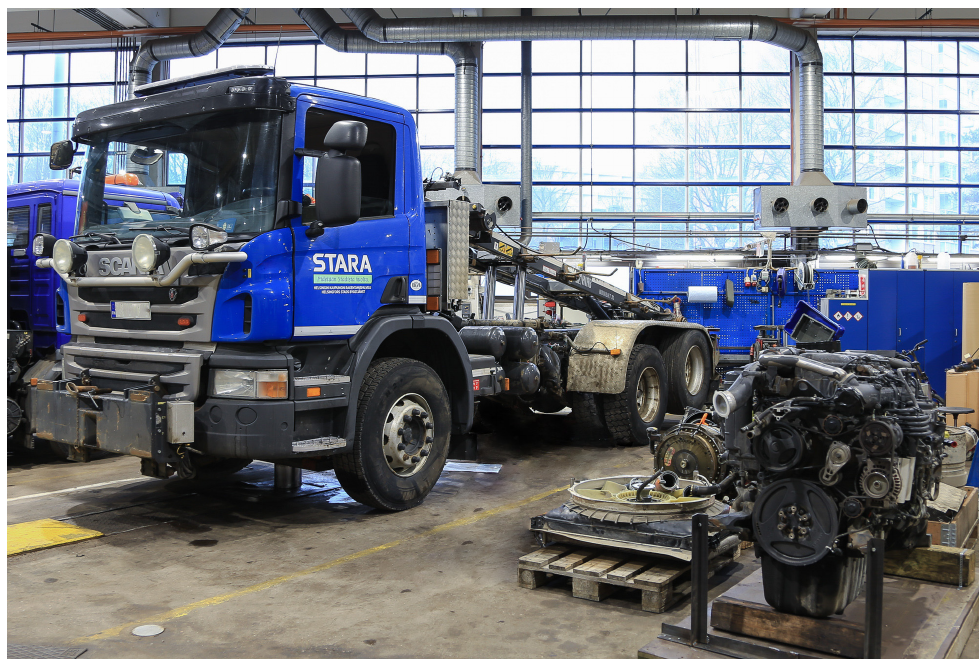
Figure 3. The original diesel truck to be e-retrofitted, together with the removed diesel engine in the lower right corner. Photo credit: Ruska Tapiovaara, Forum Virium Helsinki Ltd., Helsinki, Finland. The diesel engine has a maximum power output of 235 kW and a maximum torque of 1600 Nm. The left graph in Figure 4 describes the engine torque and power curves with respect to the rotational speed. The total efficiency coefficient for the diesel powertrain is 0.94, which is a product of the general gearbox and final drive efficiencies [19]. The fuel consumption of the engine is modelled as a function of the engine speed and respective load. The fuel rate map is derived from a specific fuel consumption map that has a generic shape and the lowest specific fuel consumption value of 192 g/kWh. Figure 5 shows the resulting fuel rate map, based on which the diesel vehicle consumption is carried out in the simulations.